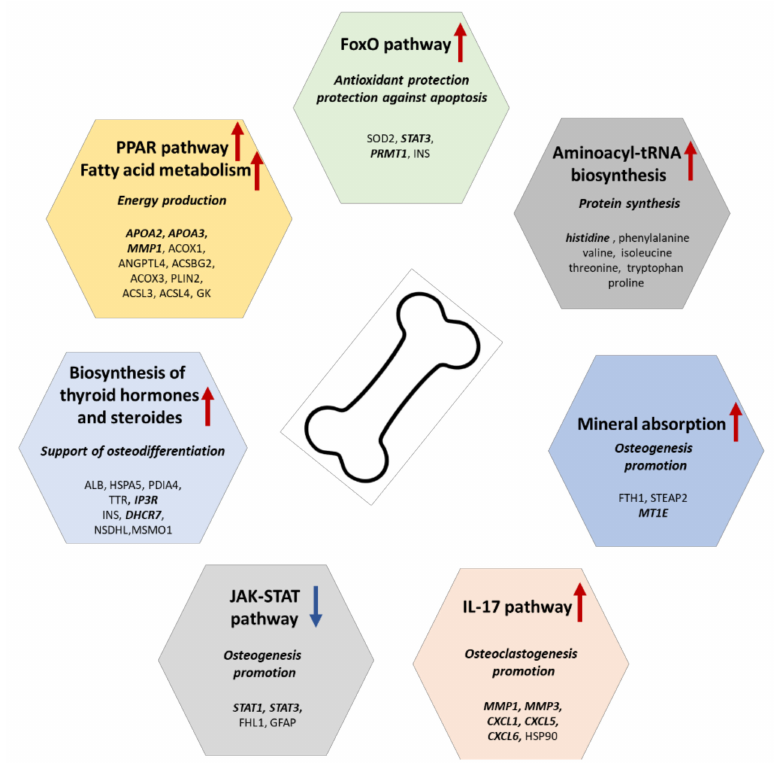
Figure 8. Summary of the proposed molecular mechanisms of osteodifferentiation. Potential biomark- ers are bold and italic denoted. Abbreviations: ALB (albumin), ACSBG2 (acyl-CoA synthetase bubblegum family member 2), ACSL1, ACSL3 (acyl-CoA synthetase long chain family